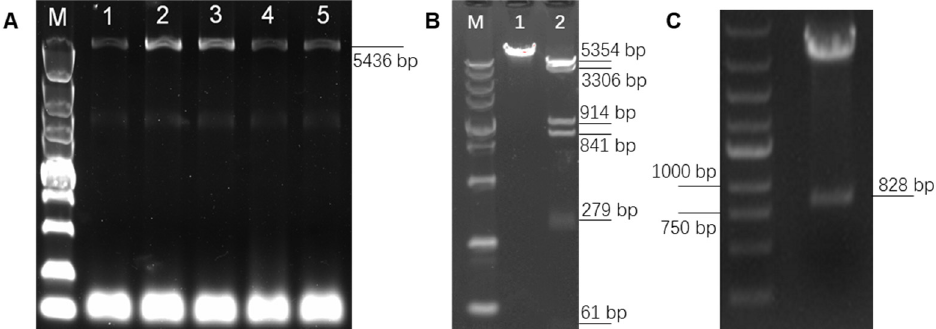
Figure 3. Construction of pPAPPA2-O and pIGFBP5-O. Note: ( A ): Full-length amplification of Hu sheep Pregnancy-Associated Plasma Protein A2 ( PAPPA2 ) CDS, lane M is DL5000 marker, lanes 1–5 are PCR products with TM of 60, 59, 58, 57 and 56 °C, which shows that the optimum TM is 58–59 °C. ( B ): Single and double digestion verification of pPAPPA2-O. Lane M is DL5000 marker. Lane 1 is pPAPPA2-O digested by Hin d III for 30 min. Lane 2 is pPAPPA2-O digested by Hin d III and Xho I for 30 min. ( C ): Double digestion verification of pIGFBP5-O using Bam H I and Eco R I. Table 4. Mutation locus of PAPPA2 CDS in Hu sheep.